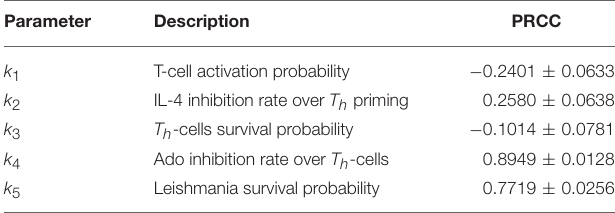
TABLE 4 | Sensitivity analysis performed on parameters k1,...,k5 with Latin Hypercube Sampling (LHS) and Partial Ranking Correlation Coefficient (PRCC) (Gomero,